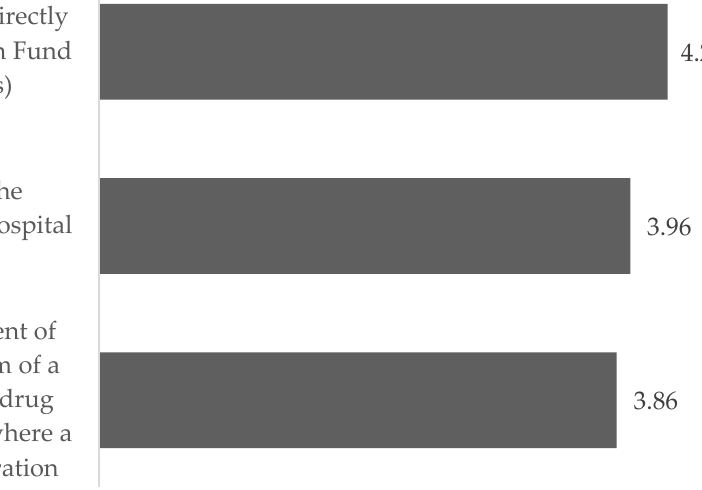
Figure 6. Assessment of the need to introduce changes in preparation of medicinal products—mean.